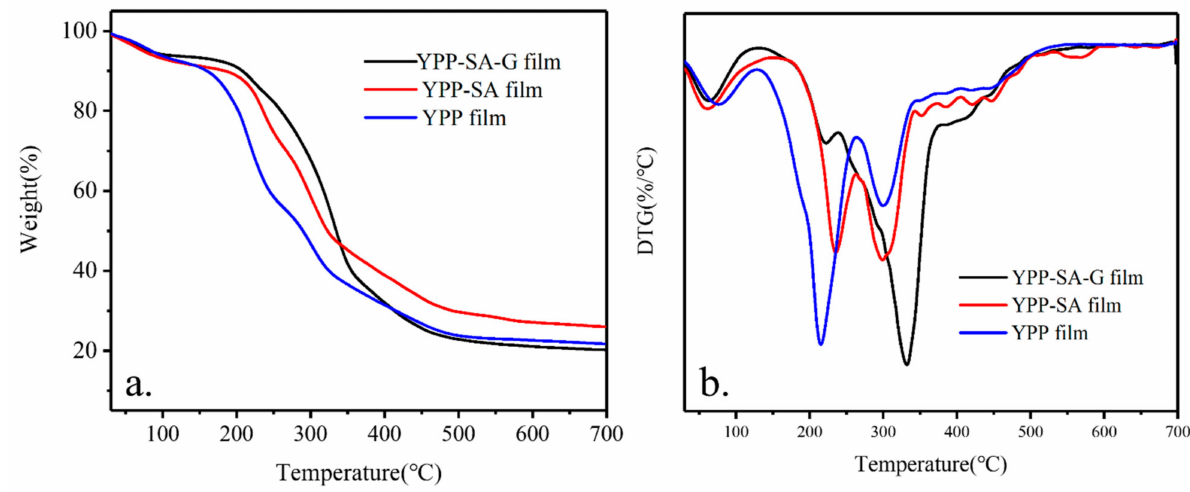
Figure 6. ( a ) TGA and ( b ) DTG curves of various films (YPP, YPP-SA, YPP-SA-G).